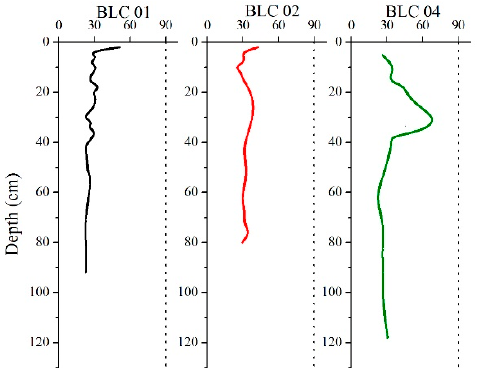
Figure 8. Vertical profiles of PERI for all core samples of Batticaloa lagoon.